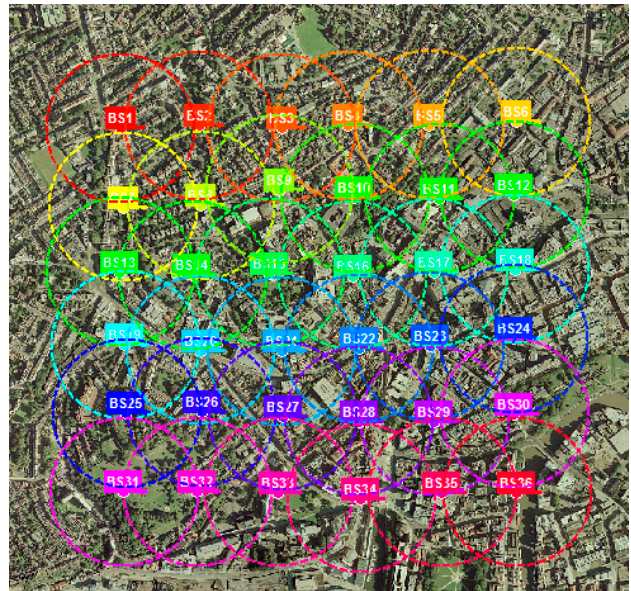
Figure 2. Base station deployment showing the coverage radius.